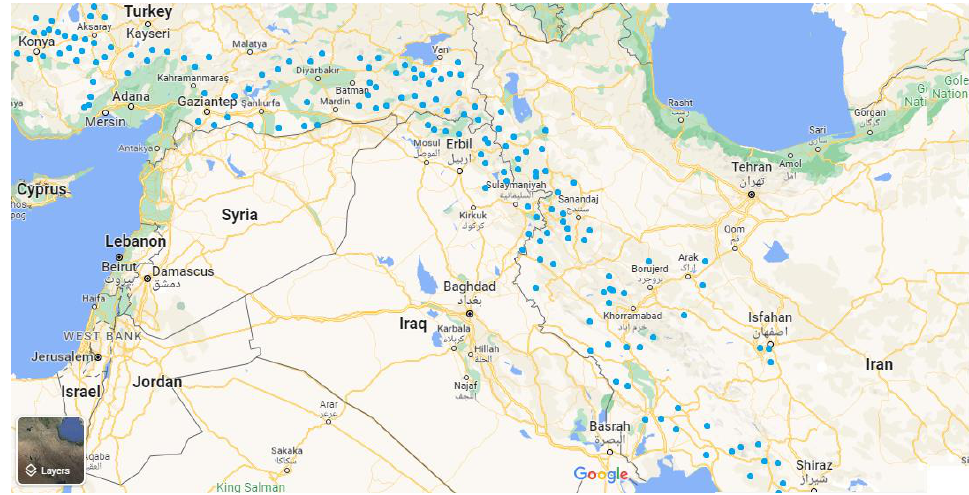
Figure 3. Regional distribution of some Onosma species in Iran, Iraq, and Turkey [4,27,29].